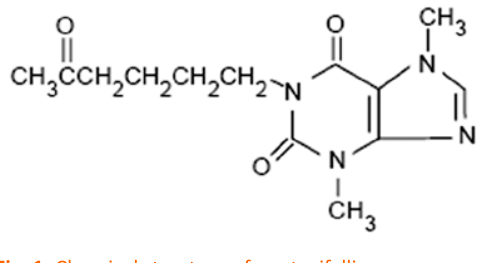
Fig. 1. Chemical structure of